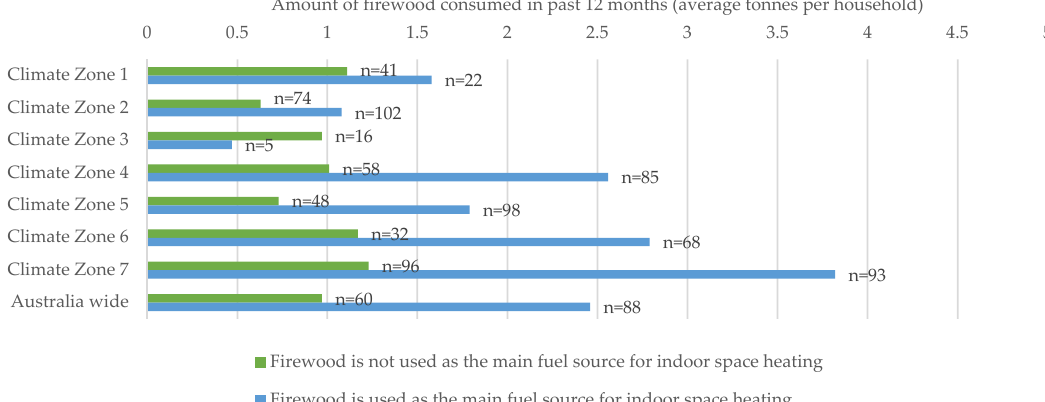
Figure 7. Average amount of firewood consumed per household in the past 12 months in each climate zone (n = 986).